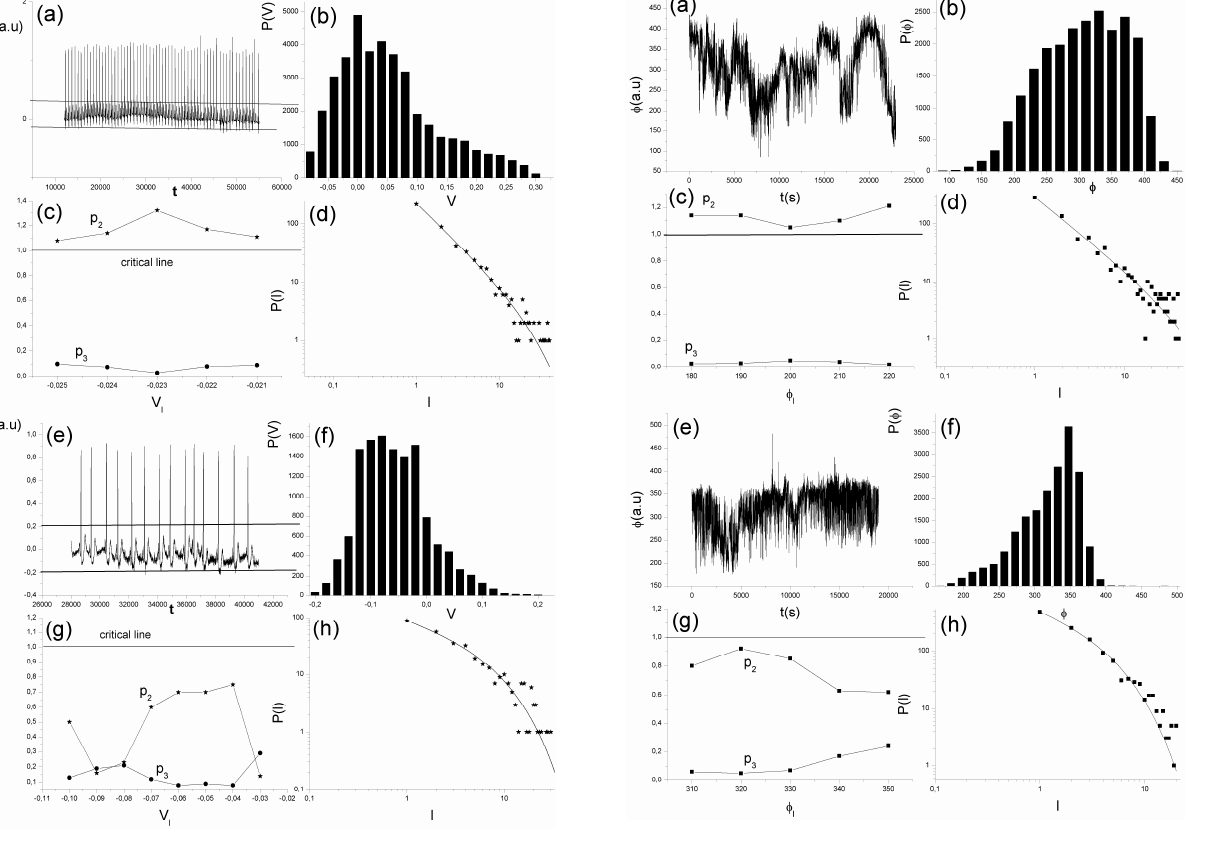
Fig. 1. (a) The ECG of the healthy subject “p121”. The analyzed times-series corresponds to the recorded voltage values, which fall Fig. 1 . (a) The ECG of the healthy subject “p121”. The analyzed times-series 7 within the interval [ − 0 . 08 , 0 . 3]. (b) The voltage-value distribution of the time series of (a) . From this distribution, the fixed point has corresponds to the recorded voltage values which fall within the interval [ ] 0.08,0.3 − . 8 been determined as V = − 0 . 06. (c) The “healthy” exponents p 2 , p 3 vs. V l (the end of laminar regions). (d) A representative example (b) The voltage-value distribution of the time-series of Fig. 1a. From this distribution, 9 of a “healthy” laminar distribution for V l = − 0 . 023. (e) The ECG for a life-threatening condition of the subject “p023”. The analyzed the fixed point has been determined as 0.06 V = − . (c) The “healthy” exponents times-series corresponds to the recorded voltage values, which fall within the interval [ − 0 . 2 , 0 . 3]. (f) The voltage-value distribution of p vs. V (the end of laminar regions). (d) A representative example of a “healthy” 11 3 l the time series of (e) . From this distribution, the fixed point has been determined as V = − 0 . 15. (g) The “pathological” exponents p 2 , p 3 V = − . (e) The ECG for a life-threatening condition of 12 laminar distribution for 0.023 l vs. V l are shown. (h) A representative example of a “pathological” laminar distribution for V l = − 0 . 1. the subject “p023”. The analyzed times-series corresponds to the recorded voltage 13 values which fall within the interval [ ] 0.2,0.3 − (f) the voltage-values distribution of 14